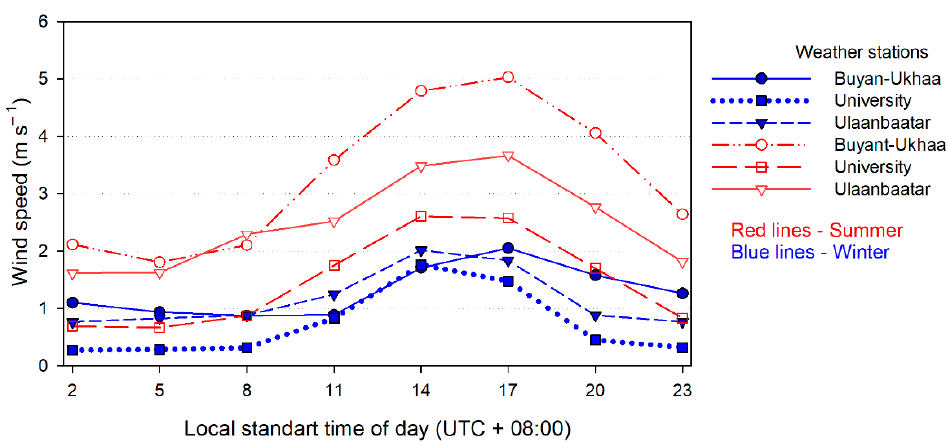
Figure 7. Diurnal variations in average wind speed in winter and summer.